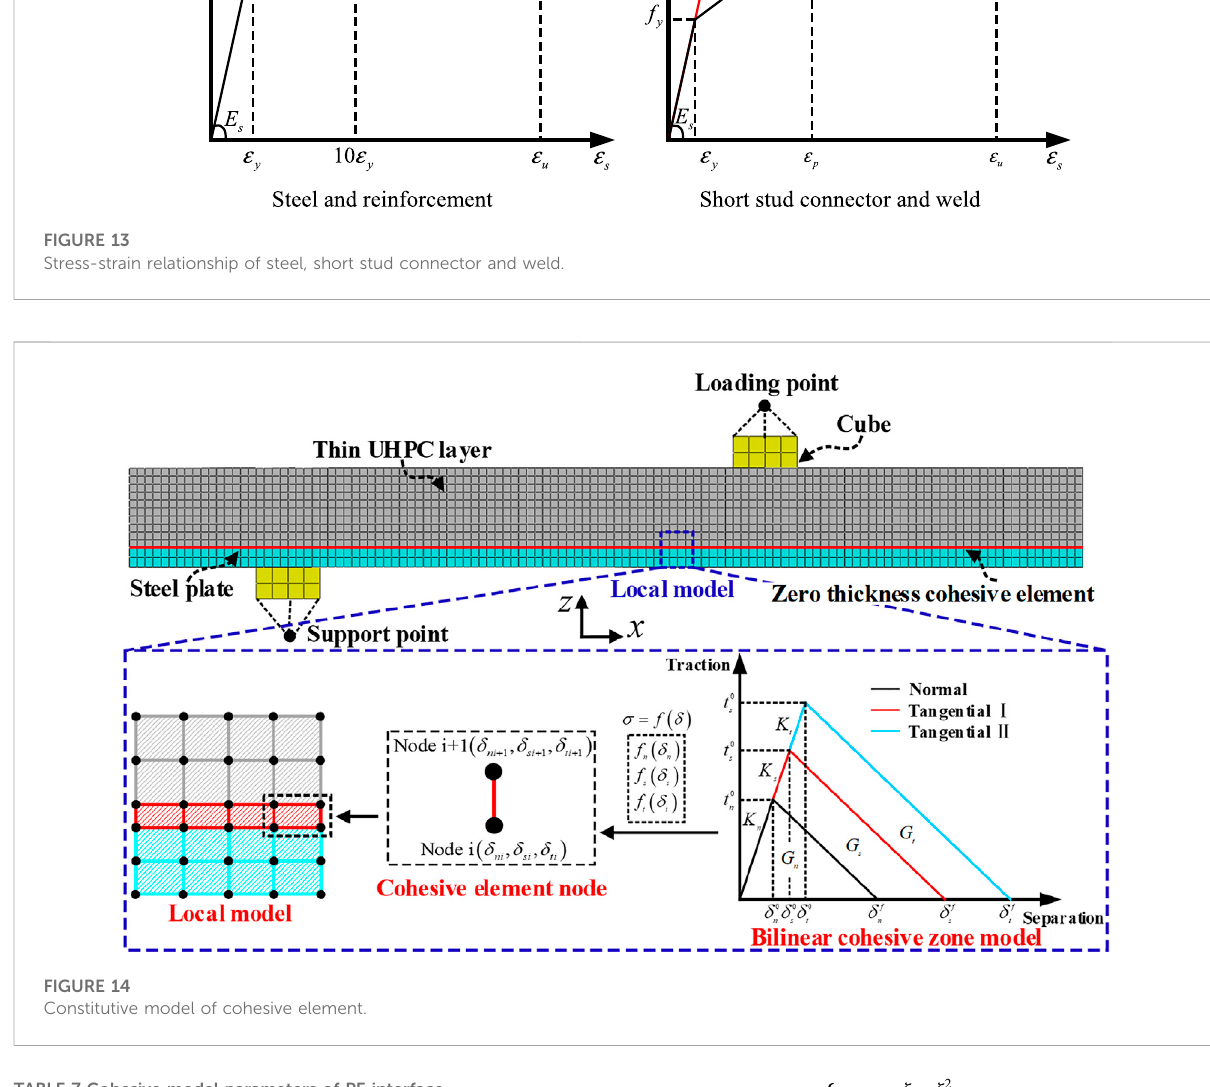
TABLE 7 Cohesive model parameters of PE